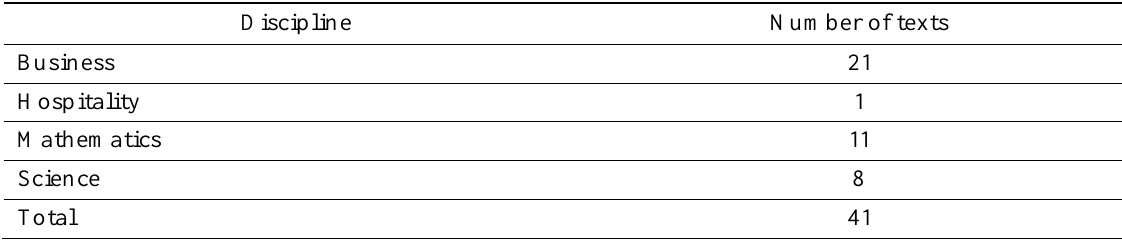
Distribution of OER Textbooks by